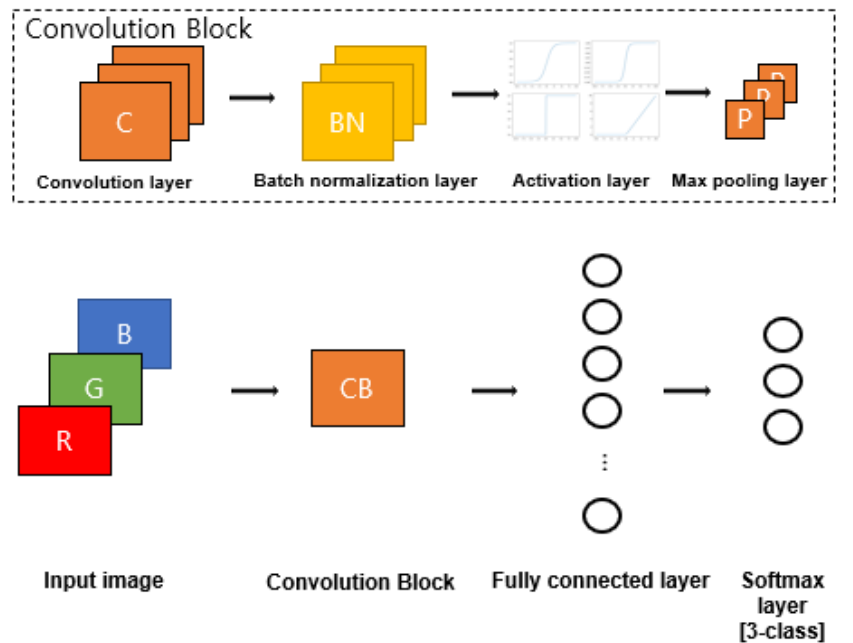
Figure 7. Brief structure of Convolutional Neural